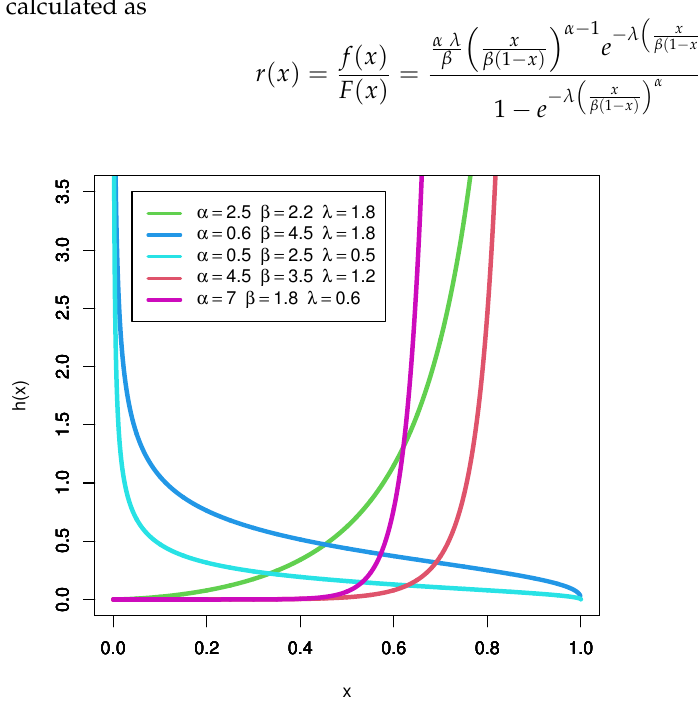
Figure 2. hazard plots of UEPD with different values of